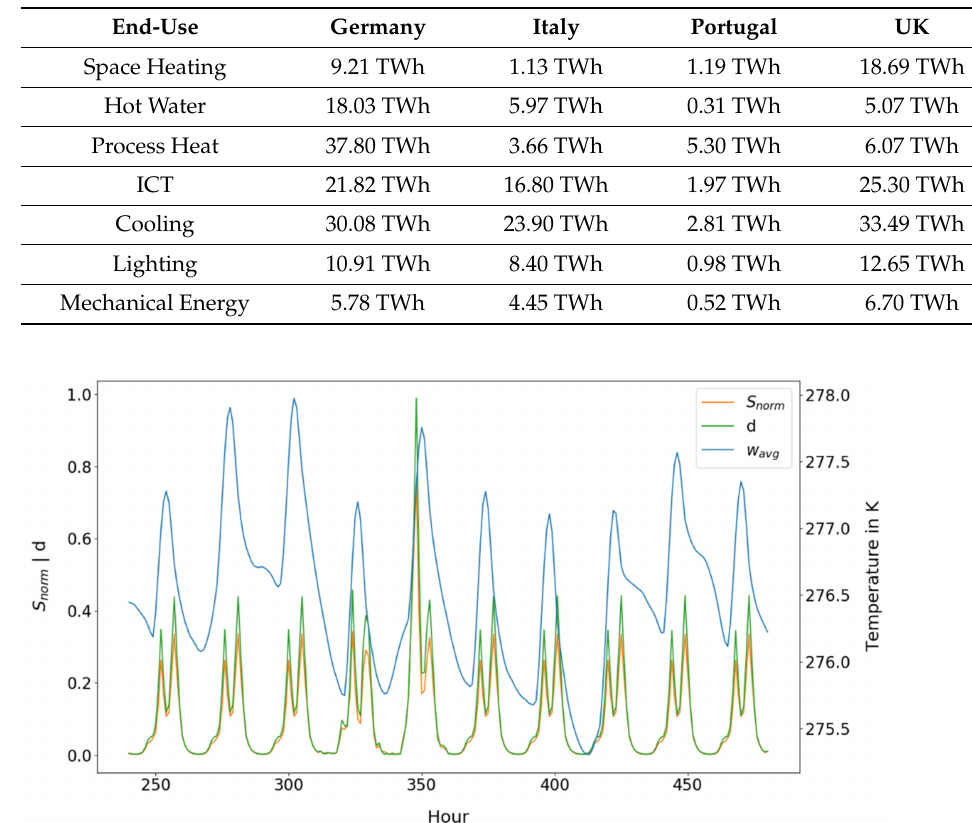
Figure A1. Example of training data for the device cooking. The plot shows an excerpt of 10 days in January. We train the neural networks to predict d from S norm and w avg and, therefore, correlate consumption data with input data that are comprehensively available. In this case of cooking, d is strongly dependent on S norm and less dependent on w avg .